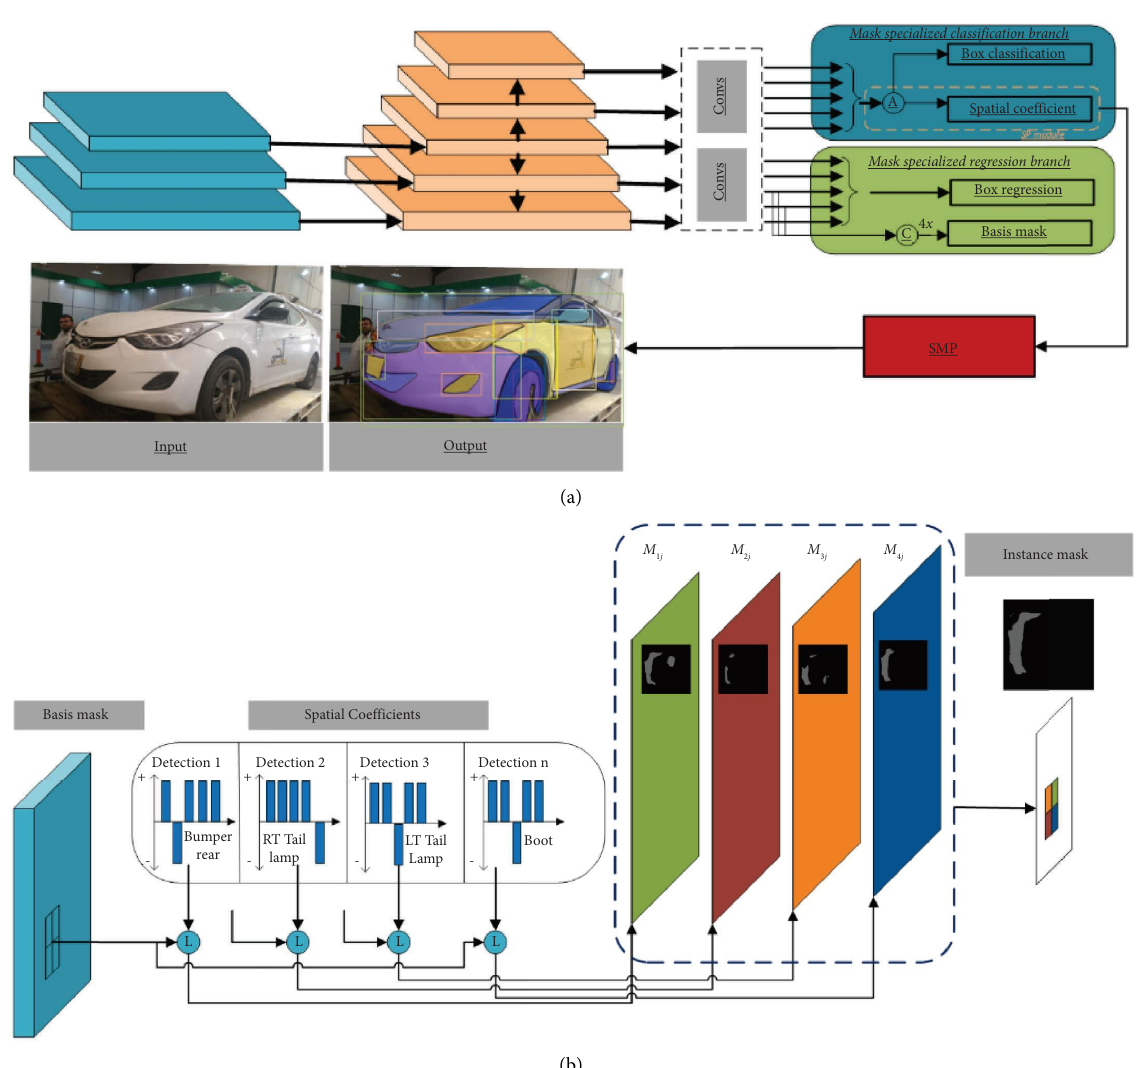
Figure 5: SipMask architecture within the car parts segmentation context covering (a) feature alignment and spatial coefcient generation process and (b) basis mask to spatial coefcient generation process leading the fnal instance segmentation of the “Bumper-rear”